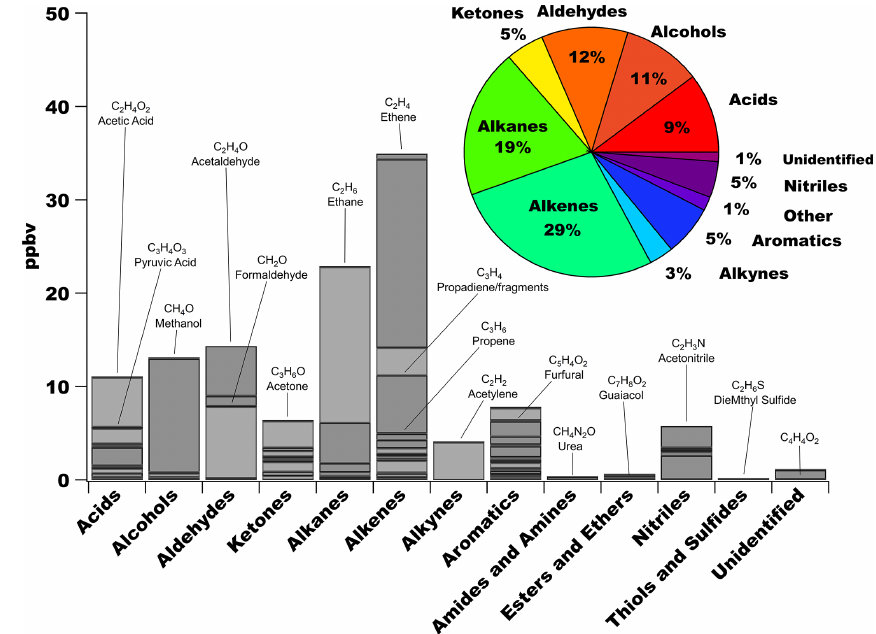
Figure 5. Background-subtracted average mixing ratios of individually measured NMOGs shown for 13 chemical classes. In some cases, compounds are double- (or triple-) counted if they can be identified in more than one category. For example, phenol is an alcohol+an aromatic; guaiacol is an alcohol+an ether+an aromatic. In the pie chart, the other category includes amides, amines, ethers, thiols, and sulfides. The unidentified category contains molecular formulas detected, but the compound(s) could not be